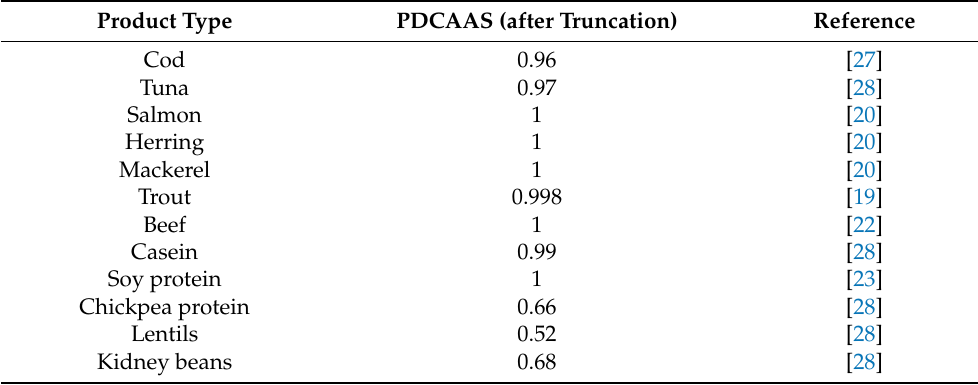
Table 2. PDCAAS (Protein Digestibility-Corrected Amino Score) for some typical animal and plant proteins.